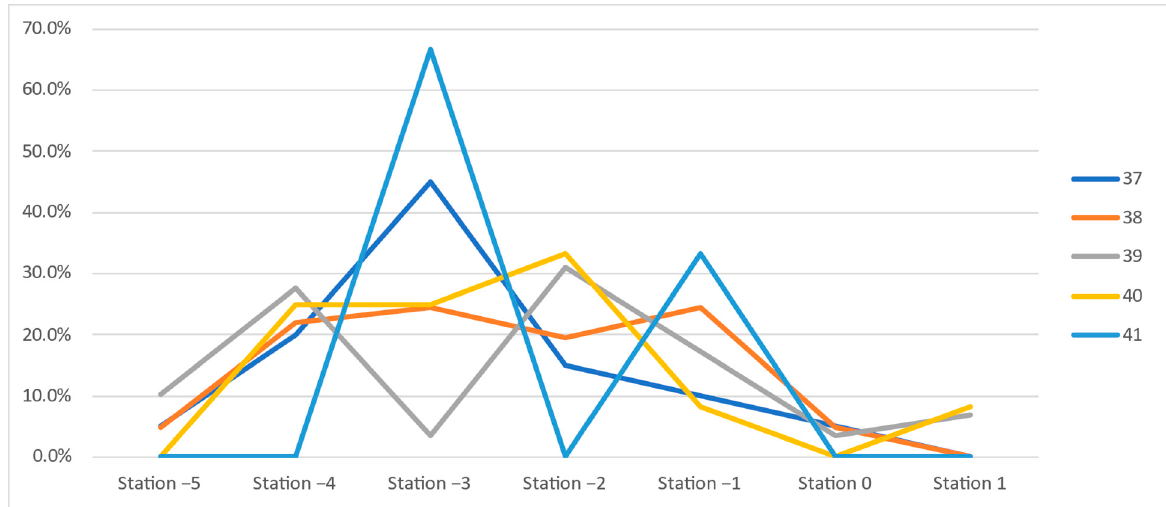
Figure 8. The rates of fetal head stations at each gestational week at term, in the group of Cesarean deliveries.